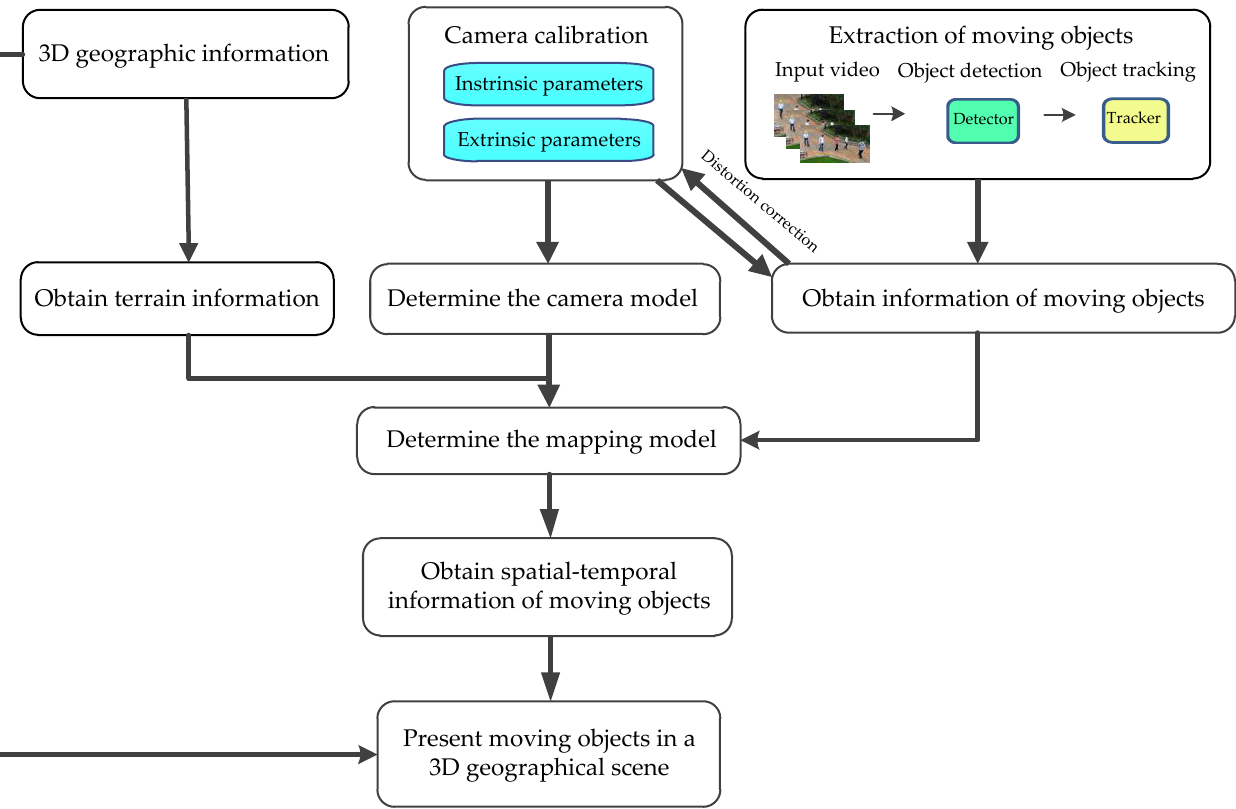
Figure 1. Fusion framework of 3D geographic information and moving objects in surveillance video.